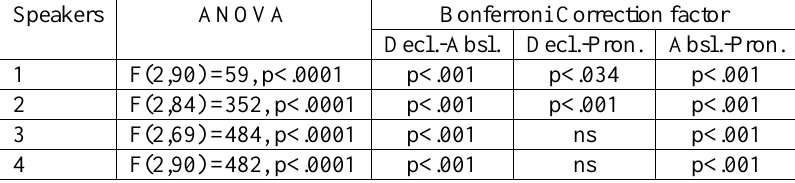
Table 3. Statistical comparisons between the nuclear Low tones of the three utterance types, ANOVA and Bonferroni correction factor. Sentence types (declarative, absolute interrogative, and pronominal interrogative) were independent factors and the nuclear Low tonal value was the dependent